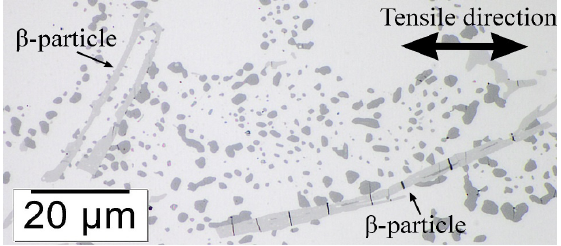
Figure 12. Cracks in a β‐ particle parallel to the tensile test direction in alloy A SDAS 25, while β‐ particle transverse to test direction show no cracking. Table 2. Measurement of β‐ particle length and one standard deviation with corresponding UTS and e f .